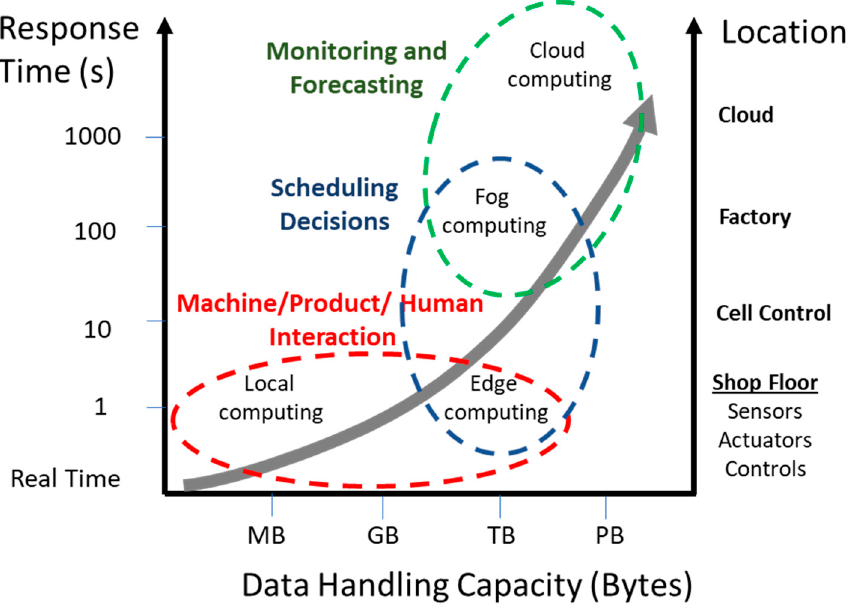
Figure 2. A frame to describe the interaction among different elements that constitute the intelligence provided by I4.0.